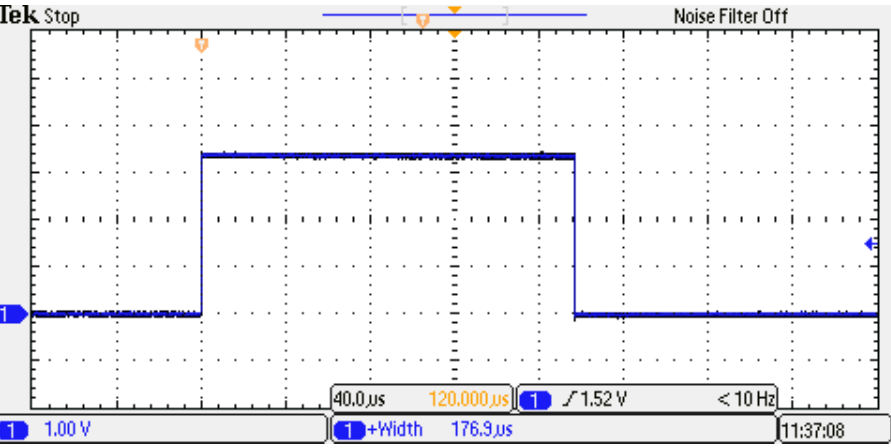
Figure 9. Measurement of the processing time of the kernel with Simulink IP implemented on the FPGA.